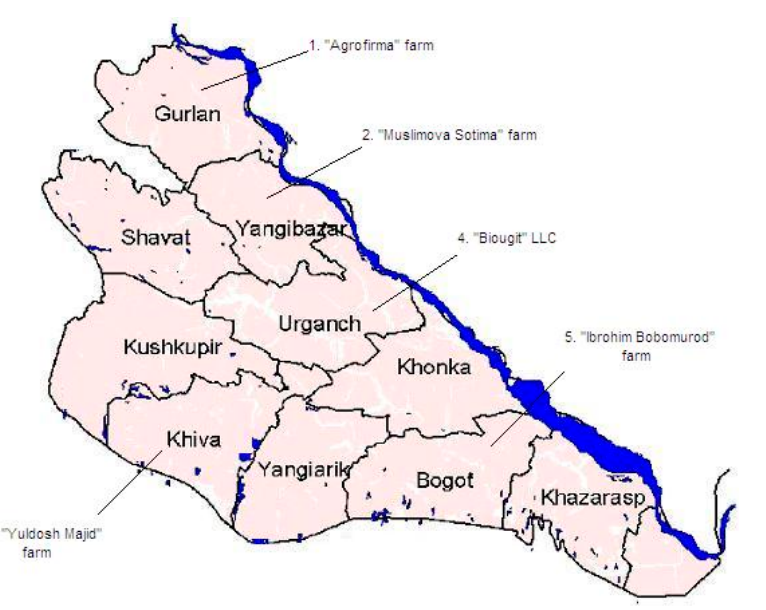
Figure 1. Map of Khorezm region and location of the five farms with high interest in biogas pro- duction.